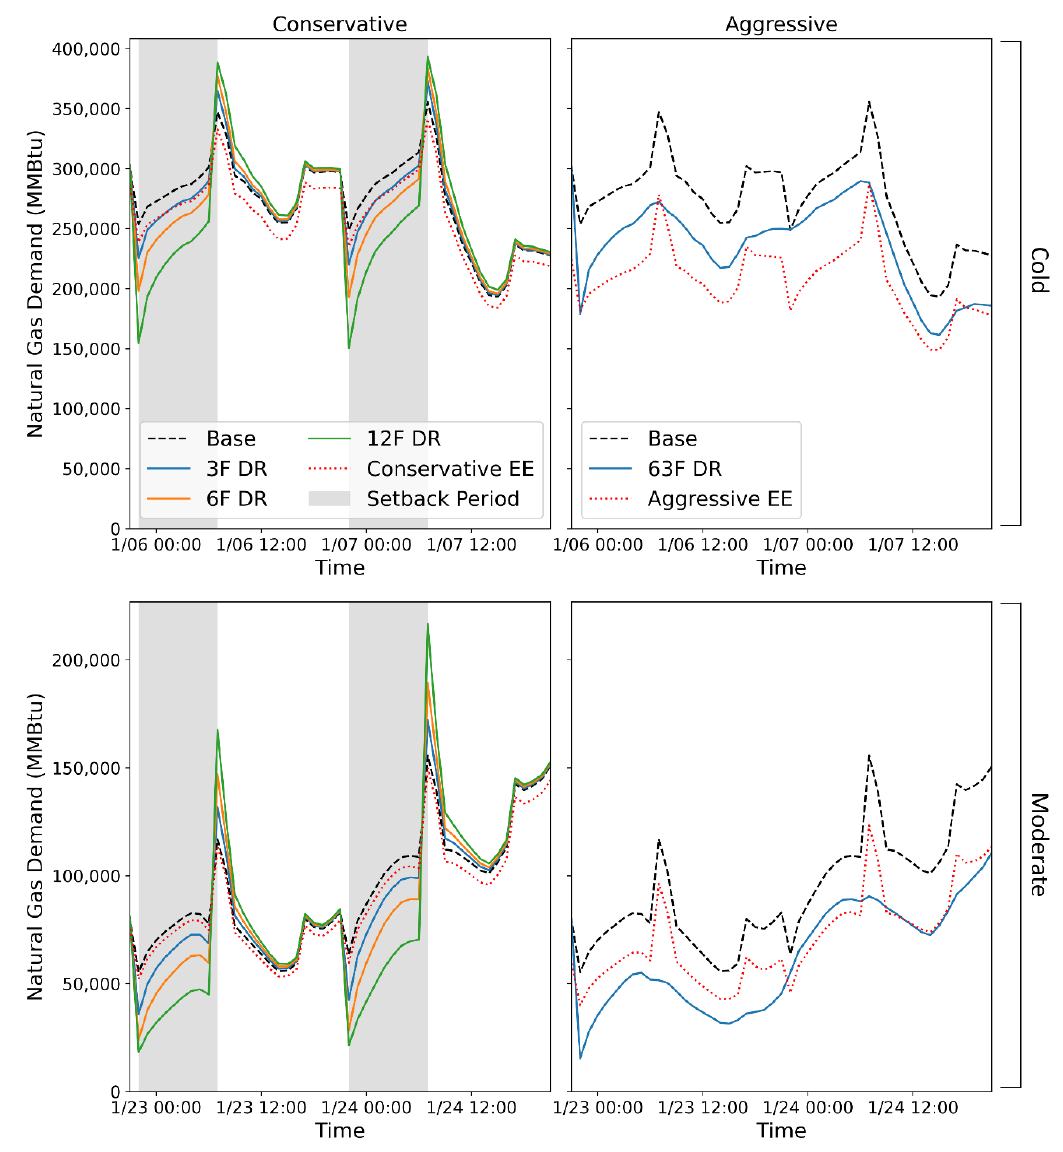
Figure 7. Total natural gas demand for heating during cold ( top ) and moderate ( bottom ) periods in 2018. Demand response (DR) and energy efficiency (EE) measures are applied to 46% of homes in the conservative scenario, and 94% of homes in the aggressive scenario. The sharp peaks and valleys shown in baseline, conservative, and energy efficiency profiles are a result of heating setbacks across homes that occur at the same time each day (i.e., not staggered).